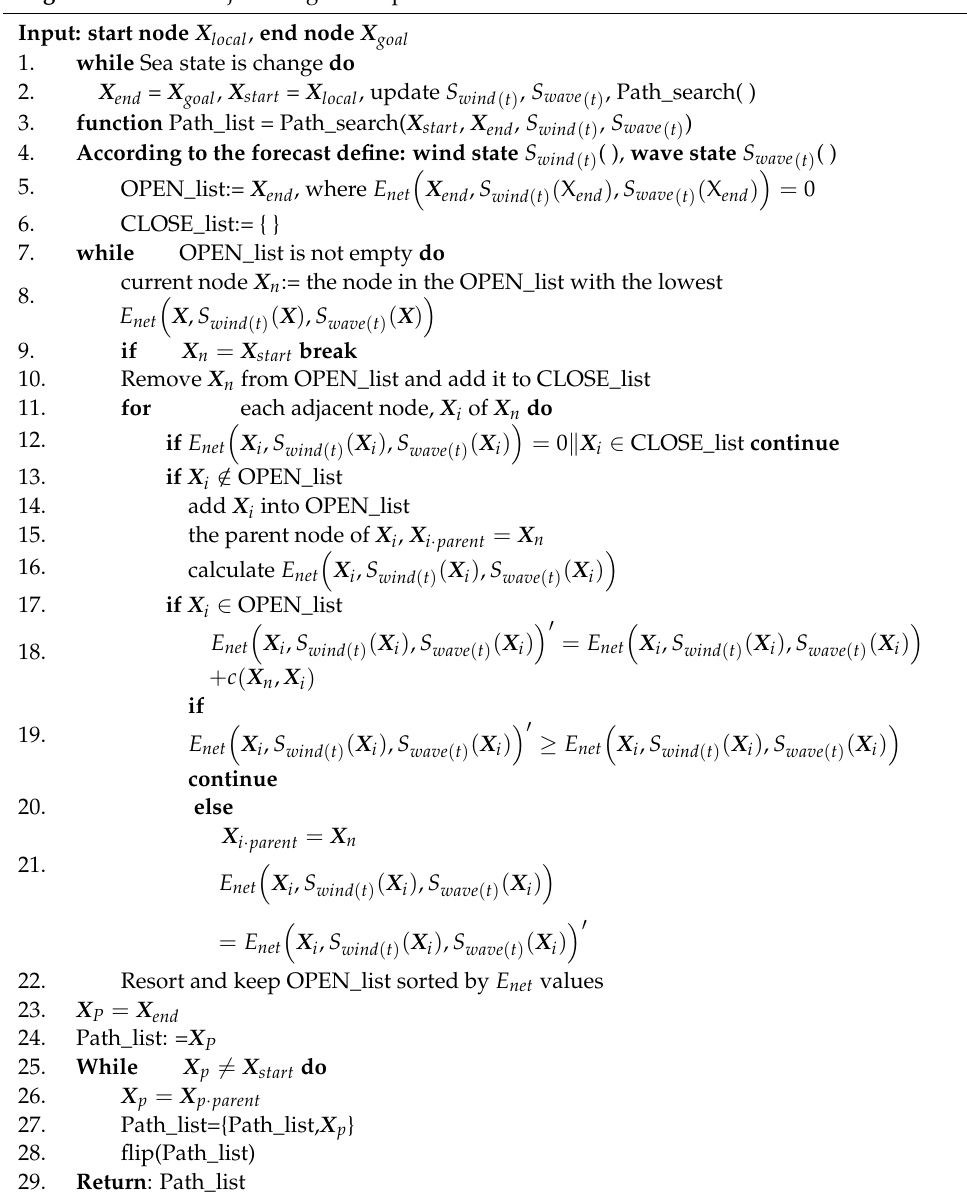
Algorithm 1: DW–Dijkstra algorithm pseudo